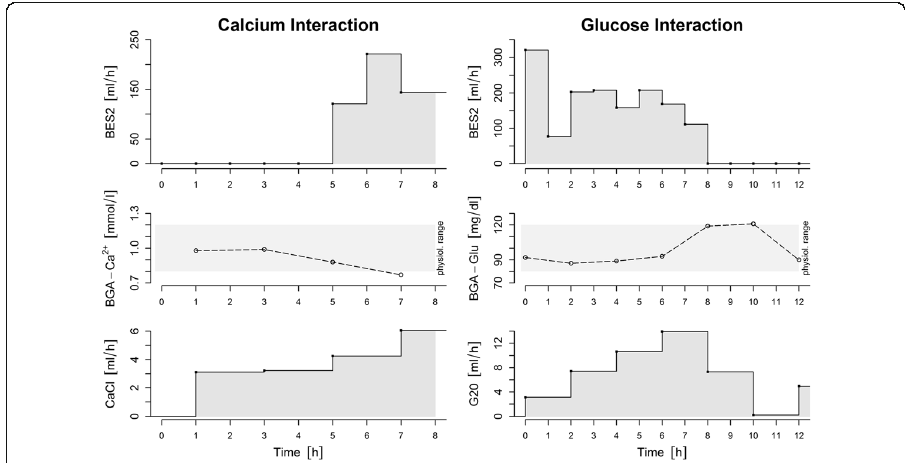
Fig. 4 Interactions between controlled parameters and variable BSE2 infusion for calcium (left) and glucose (right) with infusion rate, BGA measurement, and corresponding BSE2 infusion shown from top to